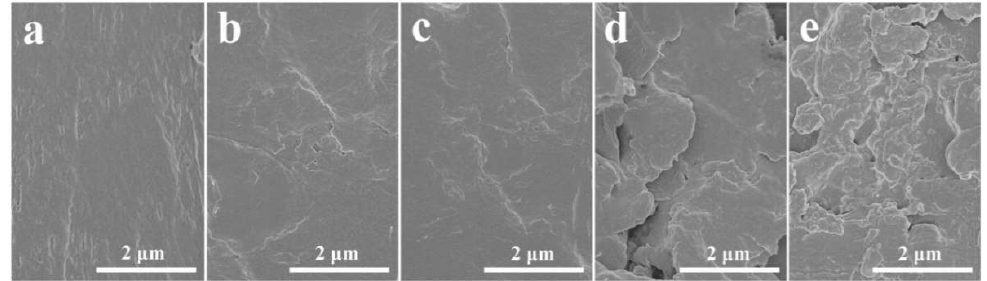
Figure 4. SEM images of tensile fractured surface for ( a ) pure PVA and PVA/g-C 3 N 4 nanocomposites with g-C 3 N 4 content of ( b ) 0.25 wt %, ( c ) 0.50 wt %, ( d ) 0.75 wt % and ( e ) 1.00 wt %.